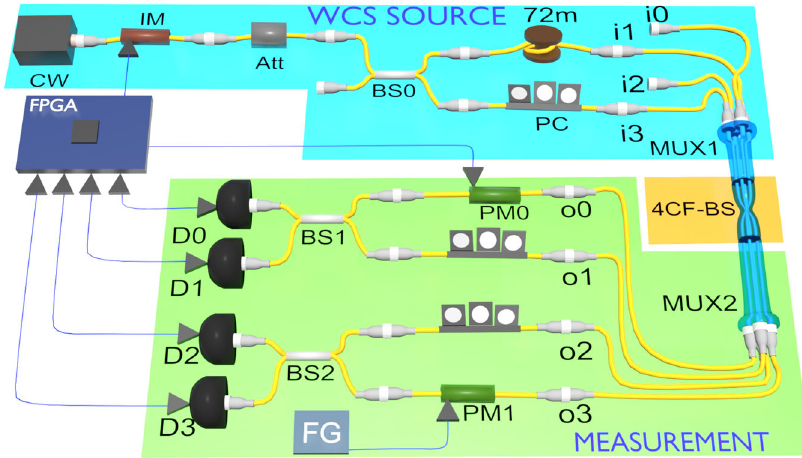
Fig. 1 Illustration of the experimental setup. Weak coherent pulses are interfered incoherently on a four-core fi ber beam splitter (4CF-BS). CW: continuous wave laser, IM: intensity modulator, Att: attenuator, BS: single-mode fi ber 2 × 2 beam splitter, PC: polarizer controller, MUX: fi ber multiplexer for single-core SMF fi ber to multicore fi ber, 4CF-BS: four-core beam splitter, PM: phase modulator, FG: function generator, D triggered single photon detector, FPGA: fi eld programmable gate array device.